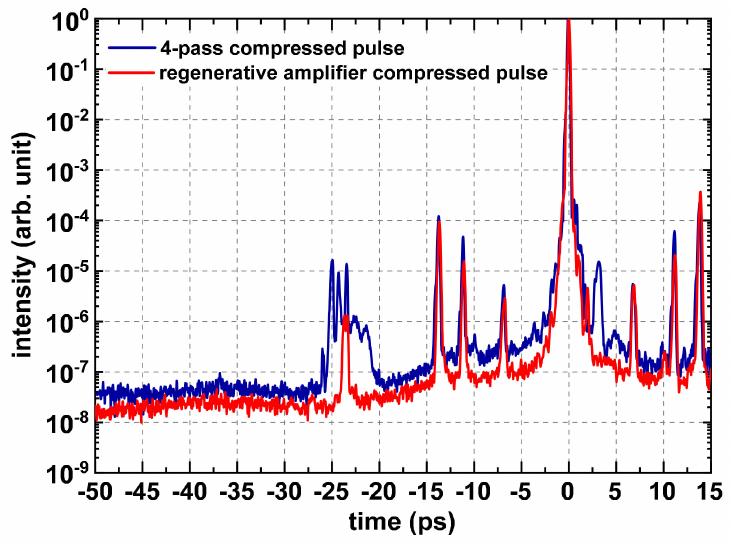
Figure 6. Amplified spontaneous emission (ASE) level of the compressed laser pulse measured by a third-order cross-correlator (Amplitude Technologies,